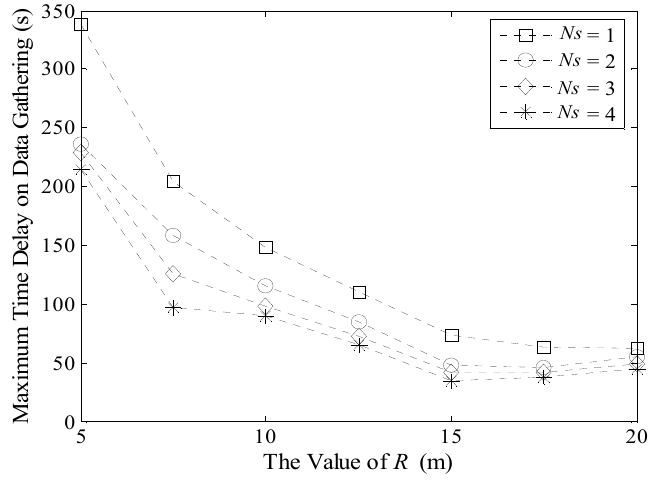
Figure 20. Maximum time delay on data gathering (100 m × 100 m, 200 nodes).